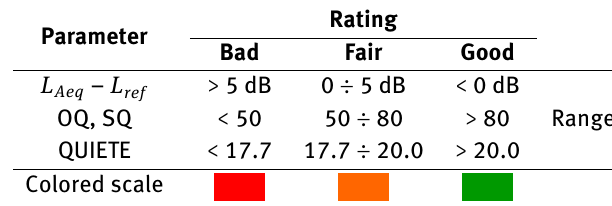
Table 3: Tentative rating scale for QUIETE index and its